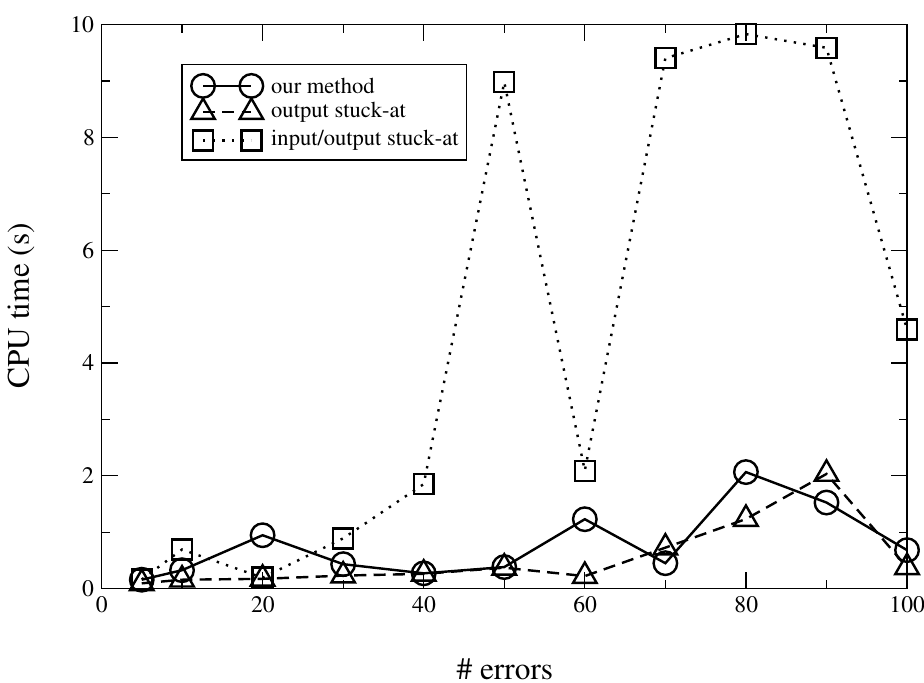
Figure 7. CPU time used by a SAT solver for processing the Boolean model of a four-input LUT implementation of b14 in the presence of multiple faults, for output stuck-ats, input/output stuck-ats and our method.